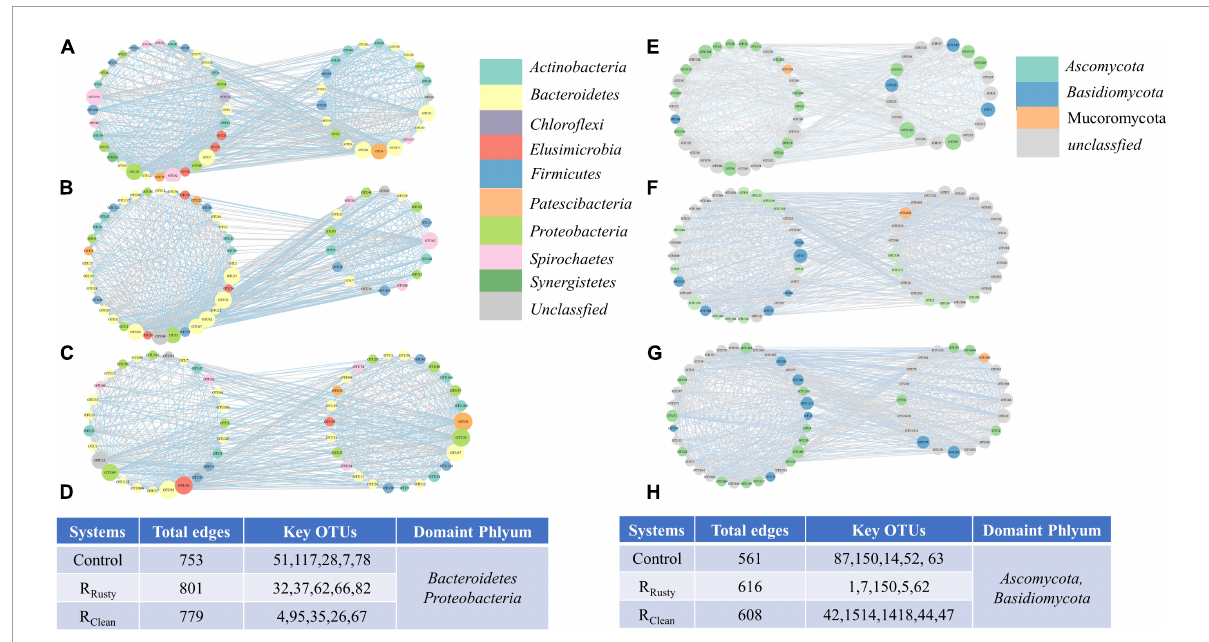
FIGURE5 (A–D) Bacterial and (E–H) fungal ecological networks of sludge in (A,E) control, (B,F) R Rusty , and (C,H) R Clean systems. Each node represents an OTU, and the size represents the number of lines. Different colors represent various species classifications (phylum